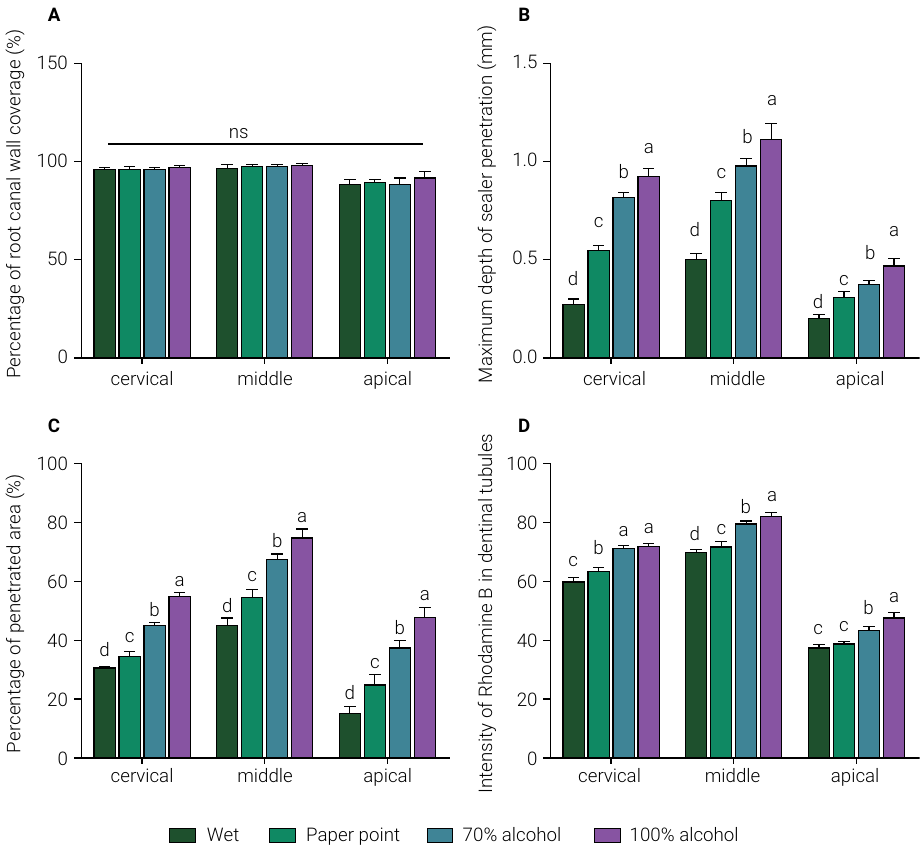
Figure 2. Representative graphics of evaluation parameters. A. Percentage of root canal wall covered; B. Maximum depth of sealer penetration; C. Percentage of penetrated area; D. Intensity of Rhodamine B in dentinal